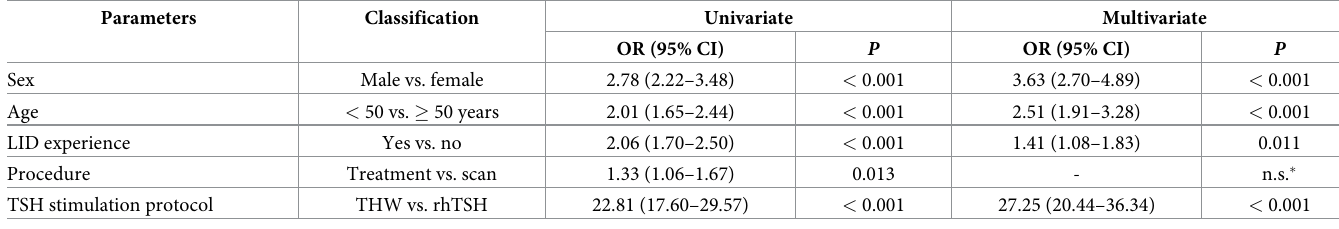
Table 5. Multivariate analysis for determinants to achieve ‘excellent’ LID